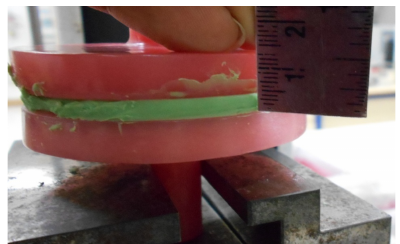
Figure 5. Heavy body material between the acrylic discs.